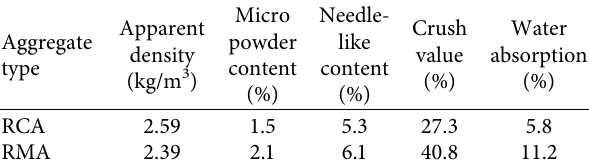
Figure 1: Macroscopic view of RA. (a) RCA, (b) RMA. Table 1: Physical properties of RCA and